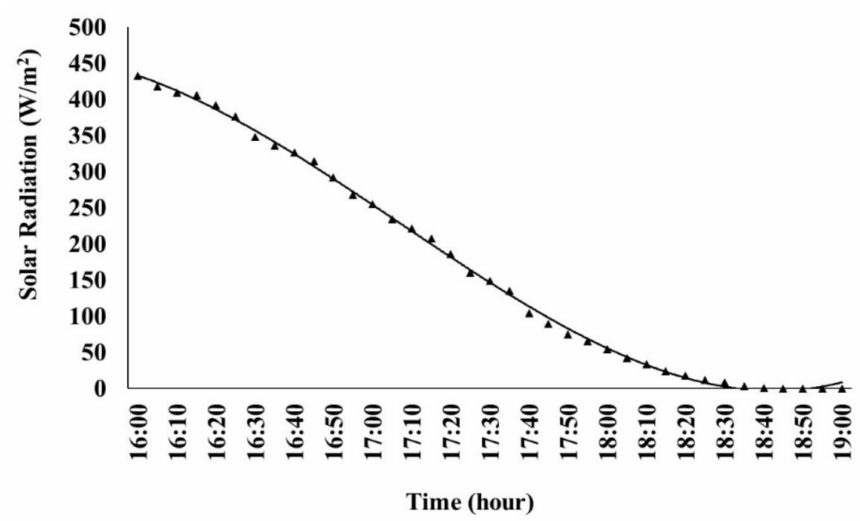
Figure 14. Variation of Solar Radiation with time on 9 April 2022.